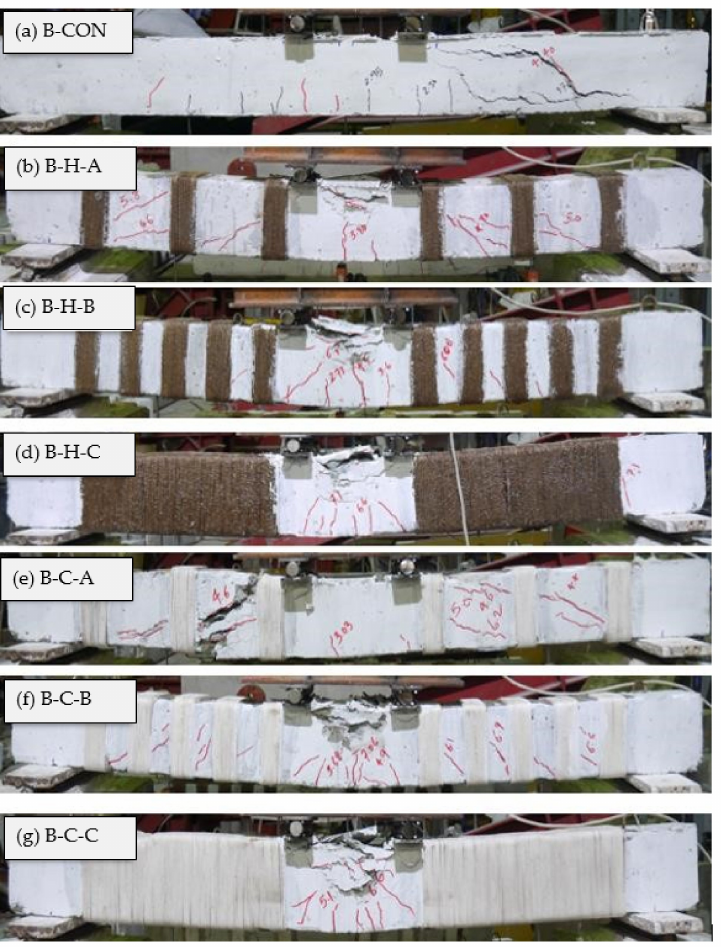
Figure 12. Failure patterns of RC beams ( a ) B-CON, ( b ) B-H-A, ( c ) B-H-B, ( d ) B-H-C, ( e ) B-C-A, ( f ) B-C-B, ( g )